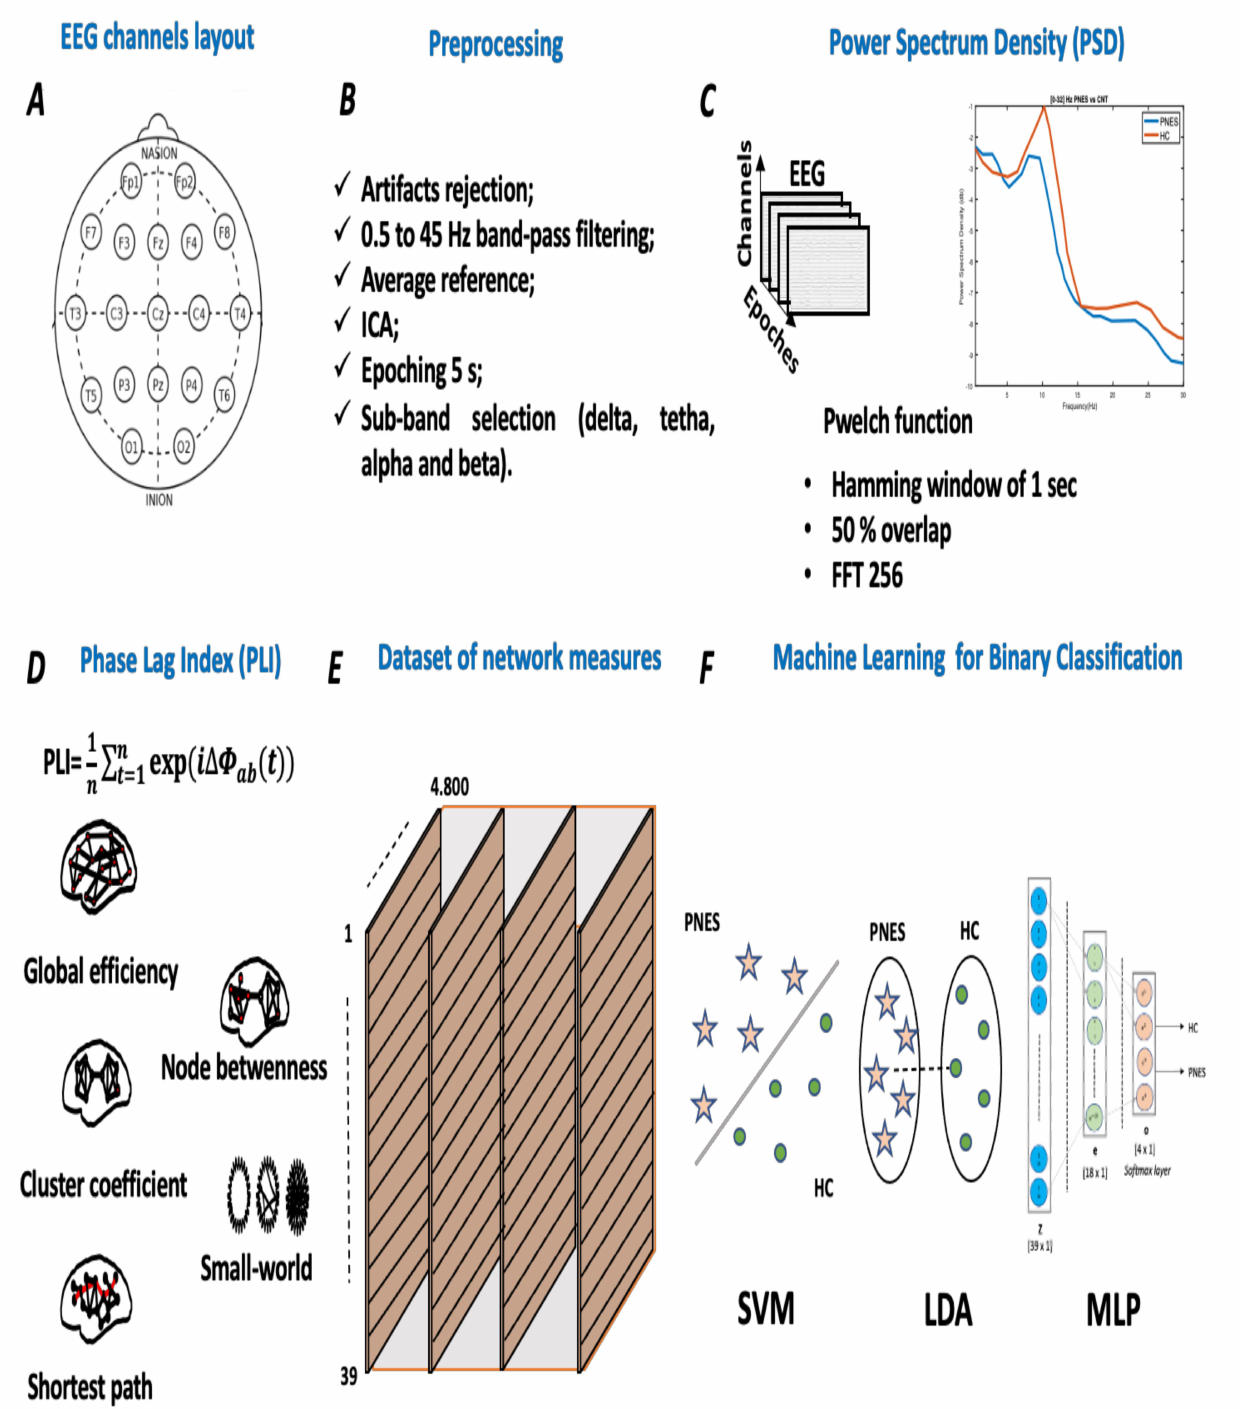
Figure 1. Flowchart of the proposed methodology. Panel ( A ) shows the international standardized 19 scalp EEG channels location. Panel ( B ) depicts the signal preprocessing pipeline used to clean the collected EEG time series. Panel ( C ) highlights the power spectral density processing, where each single EEG channel was fed in the pwelch function. Panel ( D ) depicts the EEG-based PLI network analysis. At this stage, each PLI matrix was thresholded and the adjacency matrix was computed. Panel ( E ) lists the indices used to test the performance of the network. In detail, we used global efficiency, node betweenness, cluster coefficient, small-worldness, and shortest path length, such as network indices. Panel ( F ) highlights a schematic representation of three ML classifiers, respectively, support vector machine (SVM), linear discriminant analysis (LDA), and Multilayer perceptron